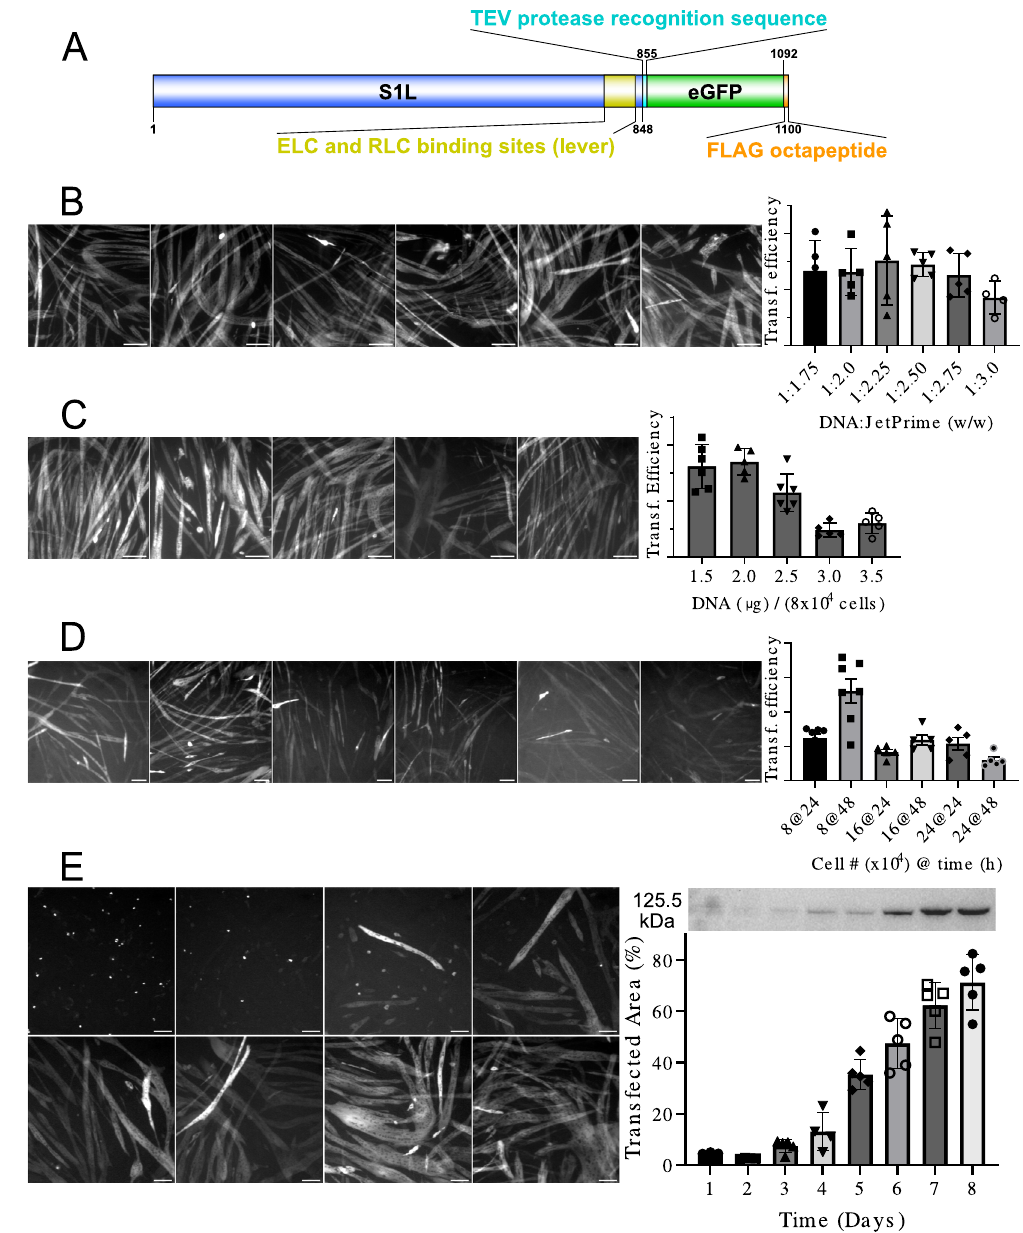
Figure 1. Optimization of transfection and expression. ( A ) Cartoon 64 of expression construct with denoted amino acid residues of specific parts. ( B ) Transfection efficiency at different DNA:JetPrime ratios. Note relatively broad efficient range where 1:2 was chosen for subsequent experiments. ( C ) Transfection efficiency at different amounts of plasmid (DNA) per seeded cell number (here 8 × 10 4 cells). The amount of 1.5 µg was chosen for subsequent experiments. ( D ) Transfection efficiency for increasing cell seeding number and two growth periods after seeding (24 and 48 h) before cell transfection. Note that increase in cell number did not improve cell transfection; seeding of the lowest number of cells with growth for 2 days gave best transfection efficiency. ( E ) Transfection efficiency assessed at each of 8 days post transfection. Right bottom : Transfection efficiency estimated as fraction of the area with GFP-fluorescence. Right top: Western blot using anti-FLAG antibodies used to quantify amount of expressed construct. Original blot is presented in Supplementary Fig. S2. All bar graphs with individual data represent mean ± SD of 3–6 images (field of views) per cell culture dish (well). Scale bars represent 100